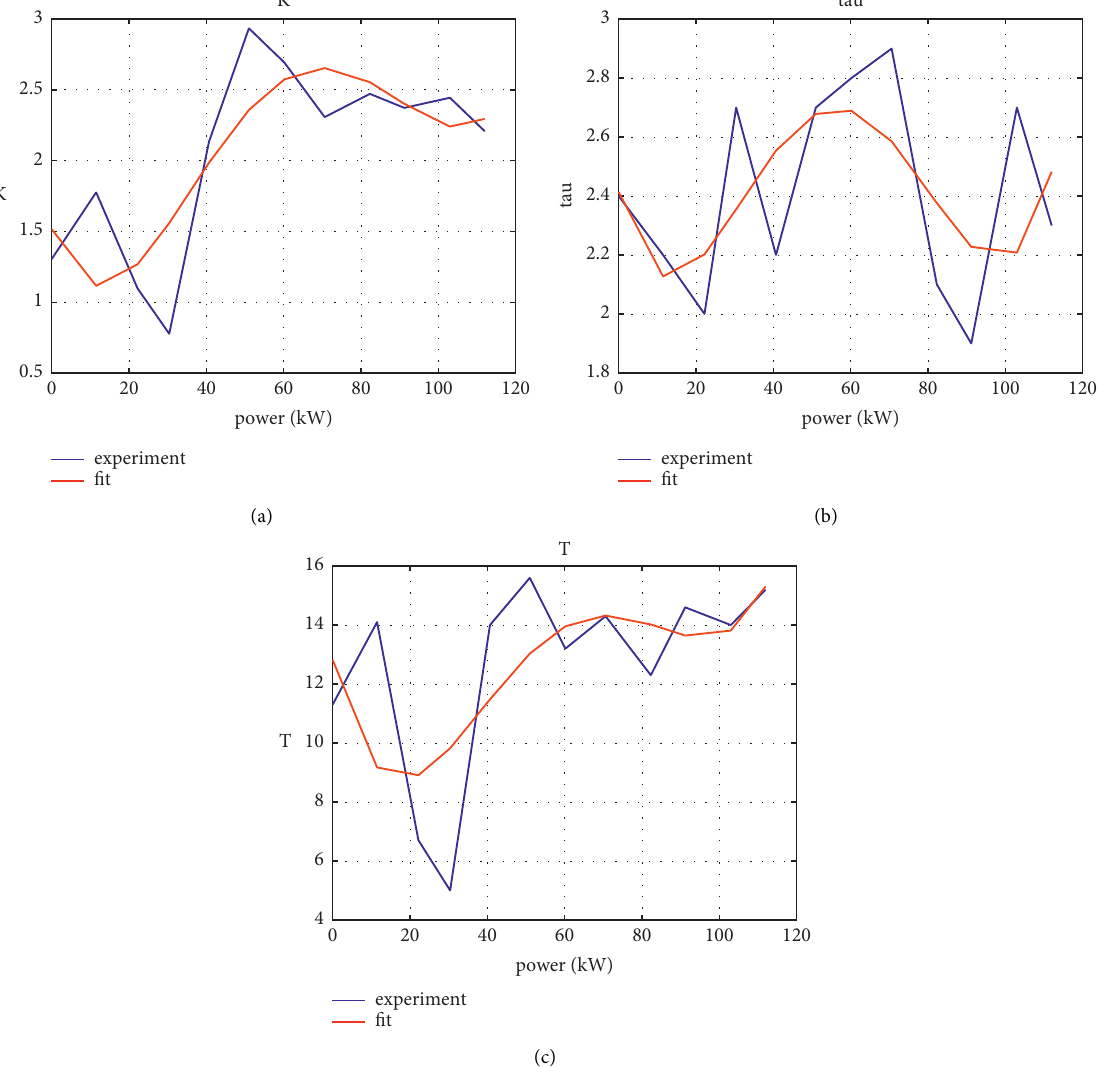
Figure 8: Comparison between fitted parameter and experimental data. (a) Steady-state gain coefficient K . (b) Time delay parameter τ (c) Time constant T egt